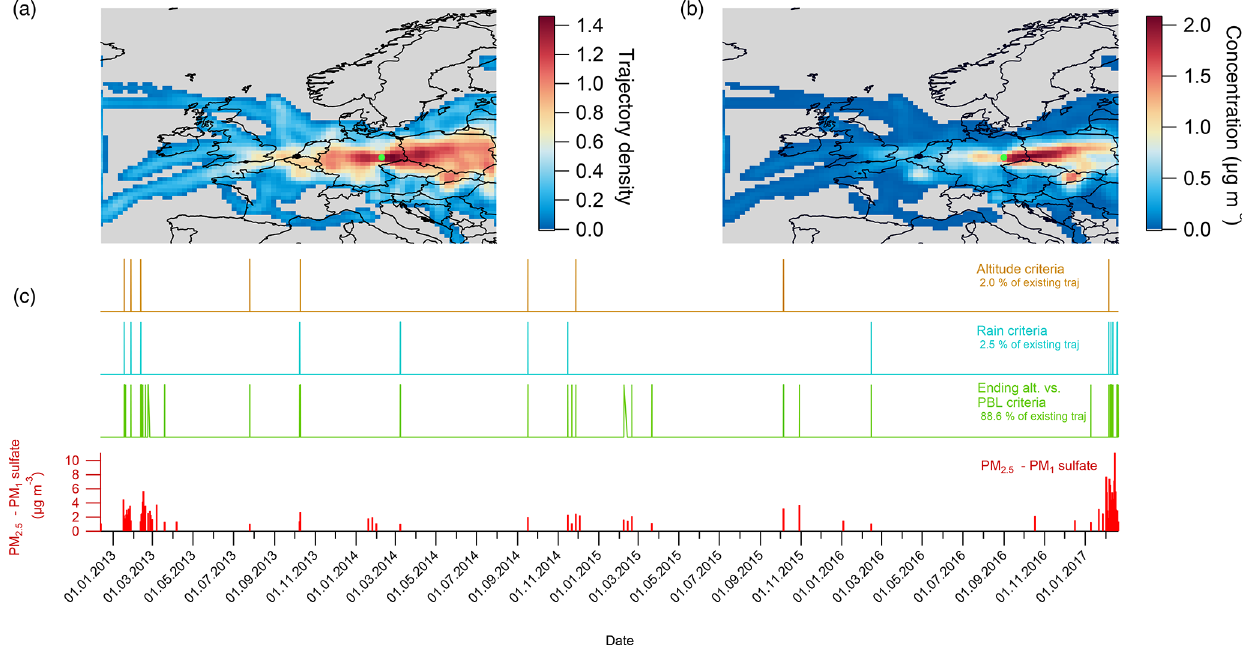
Figure 4. Trajectory analysis for days where sulfate concentration difference between PM 2 . 5 and PM 1 exceeded 1µgm − 3 : (a) overpassing trajectory density; (b) results of the potential source contribution function (PSCF) analysis; (c) time series of sulfate mass concentration difference, trajectory altitude above 2000m, precipitation events exceeding 1mmh − 1 , and PBL above the station <